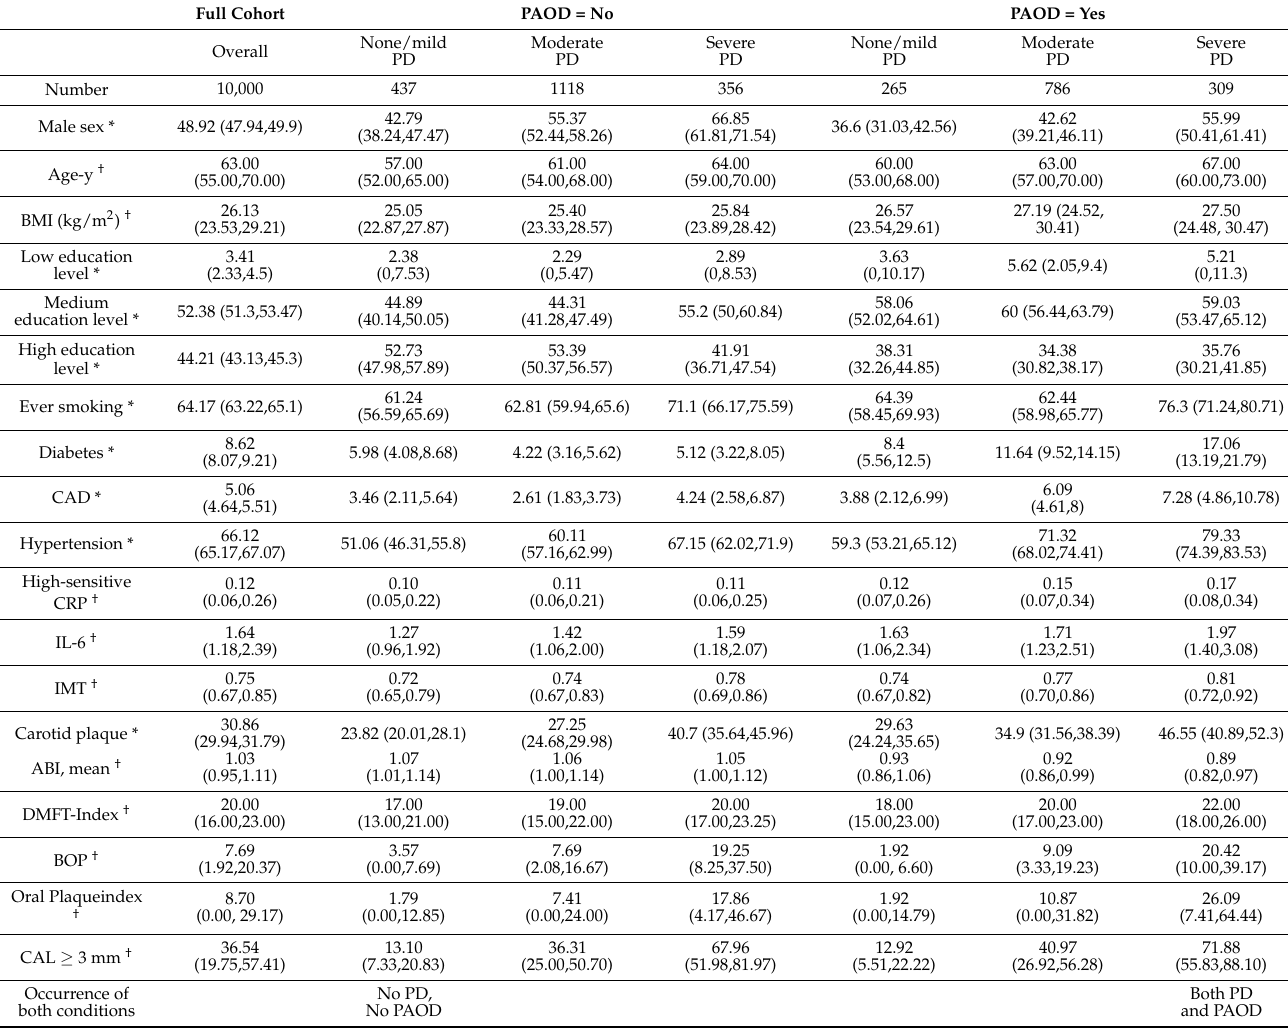
Table 1. Baseline characteristics from all (N = 10,000) participants and participants with complete vascular and oral examination (N = 3271) enrolled in the Hamburg City Health